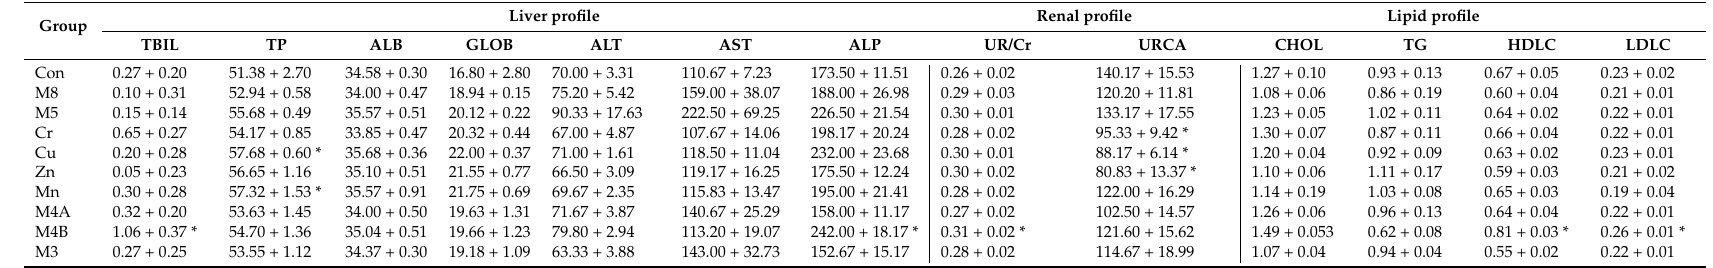
Table 4. The biochemical analysis of the liver, renal and lipid profiles.